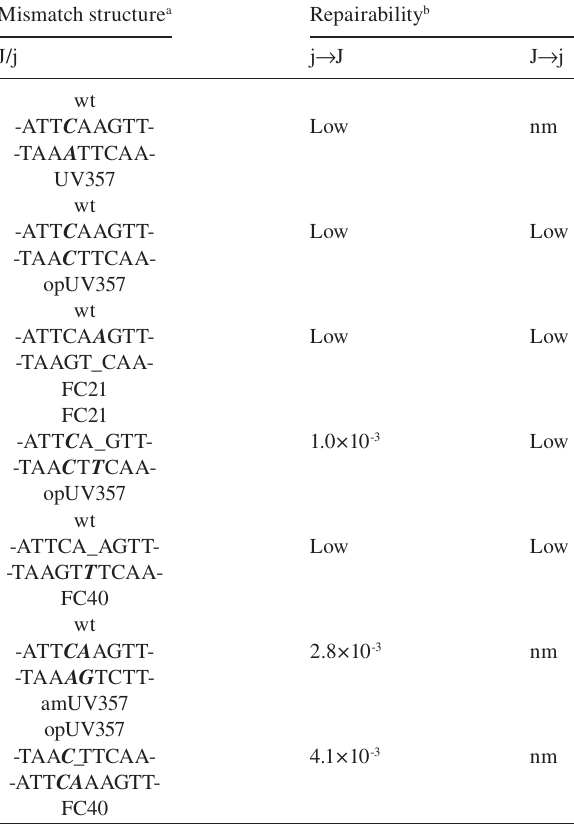
Table 1 Structures and repairability values for some of the mismatches formed in crosses of rIIB mutants (47)